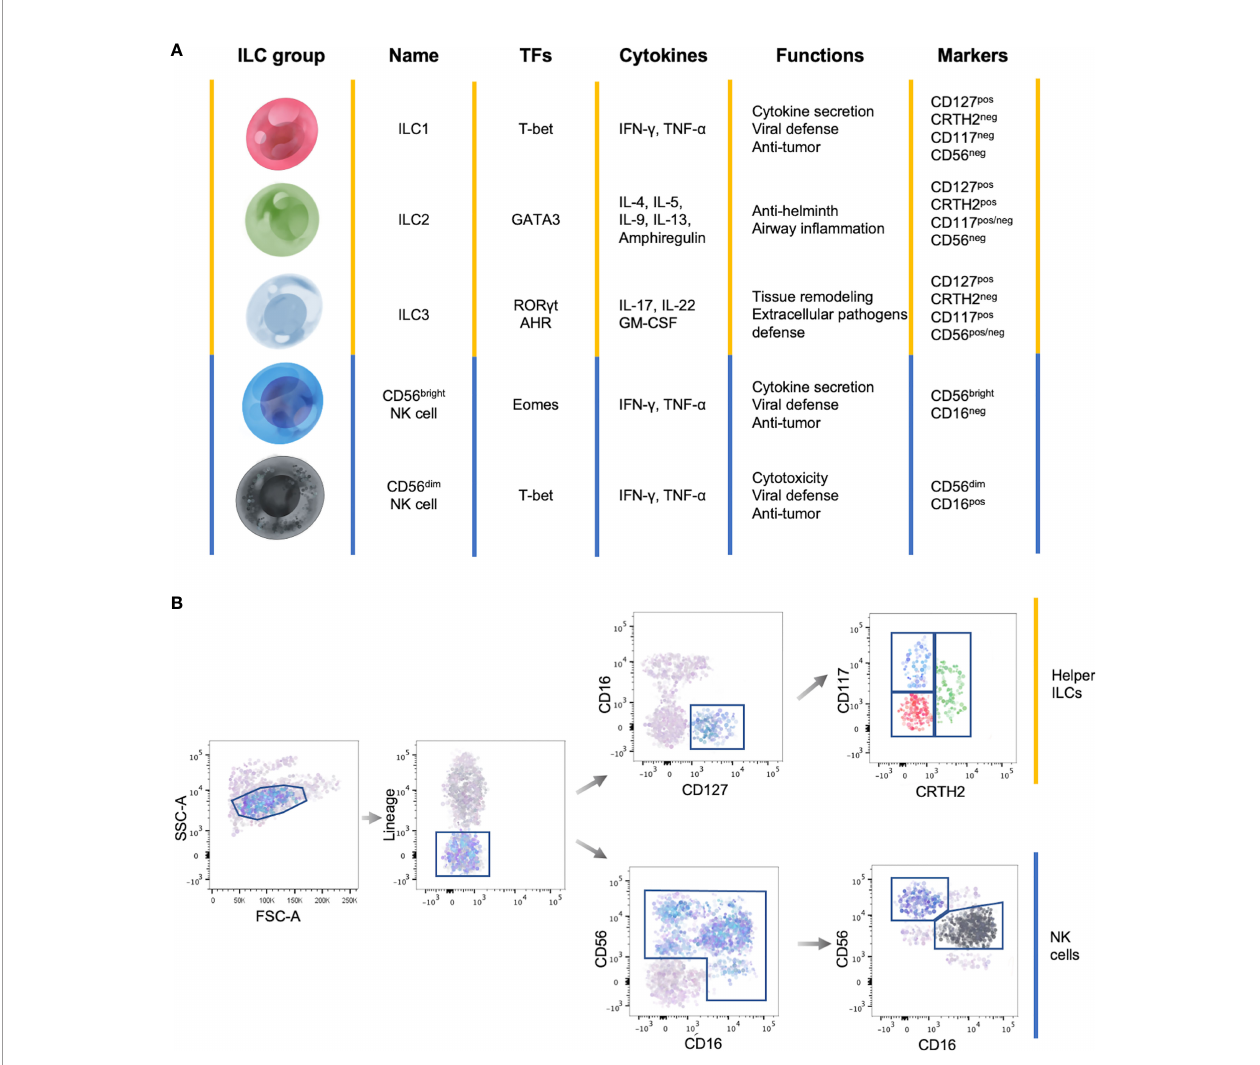
FIGURE 1 | General features of ILC subsets. (A) Summary table showing the main transcription factors (TFs) governing the development, the cytokine production, the functions and marker expression in the different ILC subsets. (B) Representative fl ow cytometry gating strategy to identify circulating ILC subsets among Lineage neg lymphocytes. Yellow lines identify helper ILCs, while the blue lines identify NK